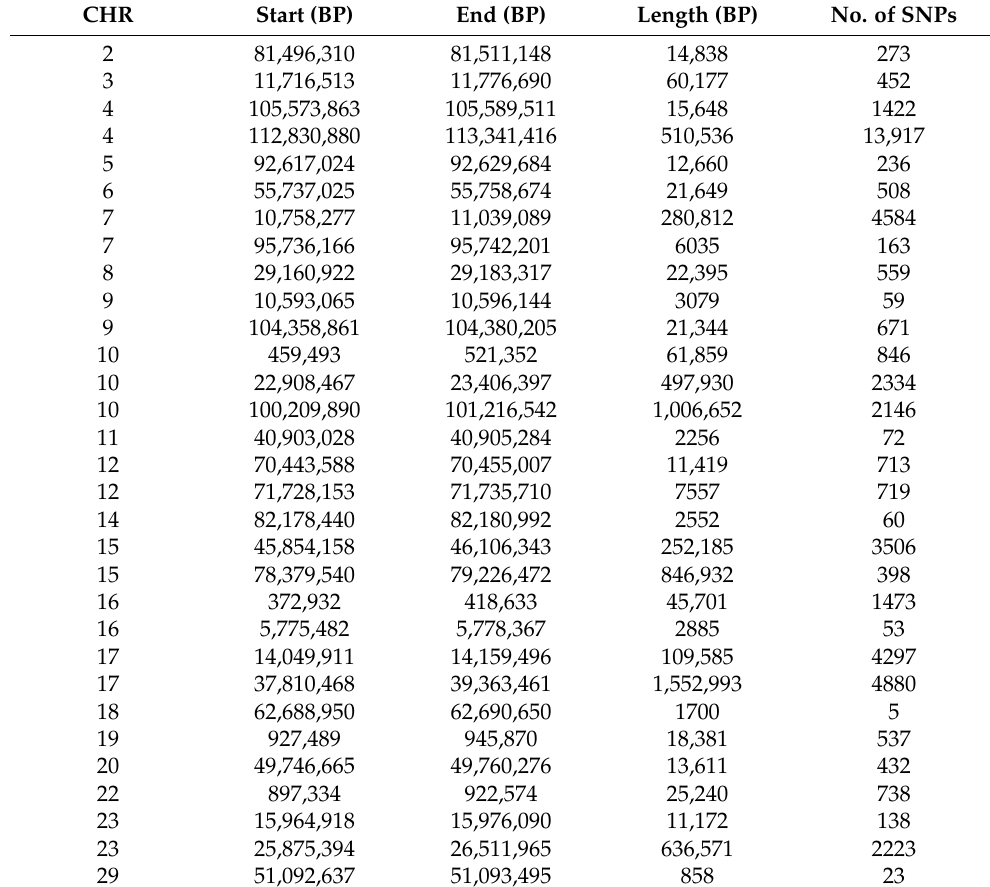
Figure 6. Plot of imputation accuracy against distance of SNPs from nearest end of chromosome (Mb). Table 8. Chromosomal position of poorly imputed genomic regions in